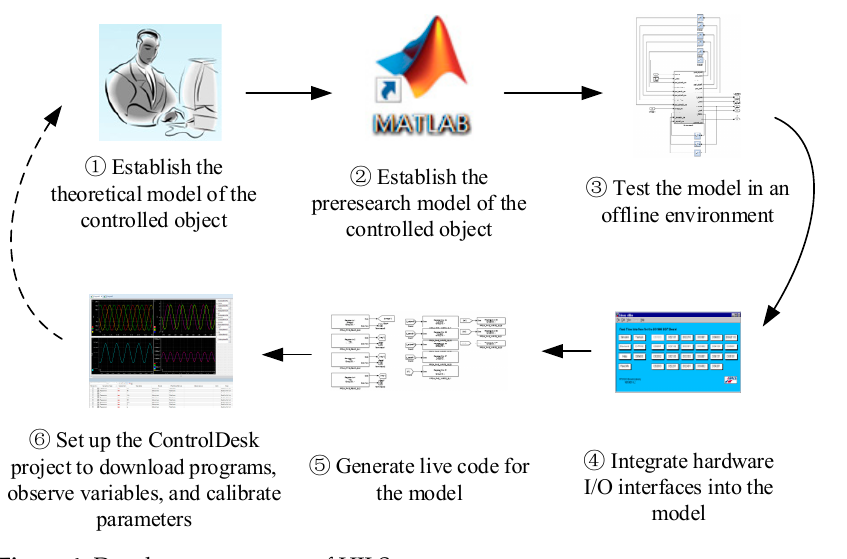
Figure 4. Development process of HILS.